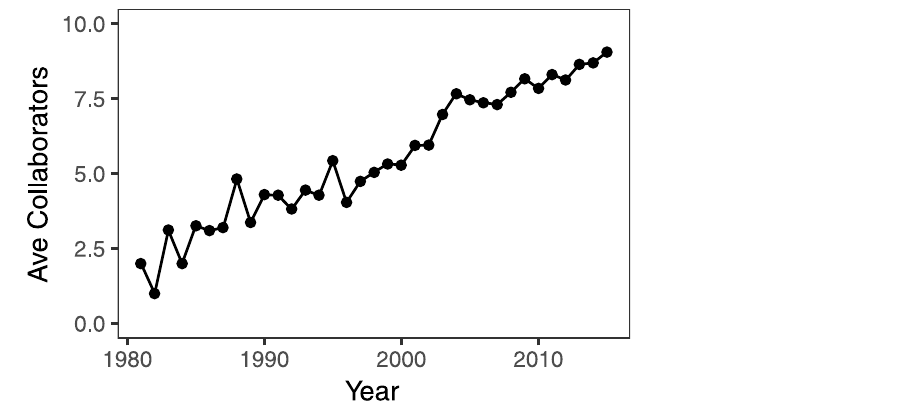
Fig 3. Average number of collaborators per author per year.